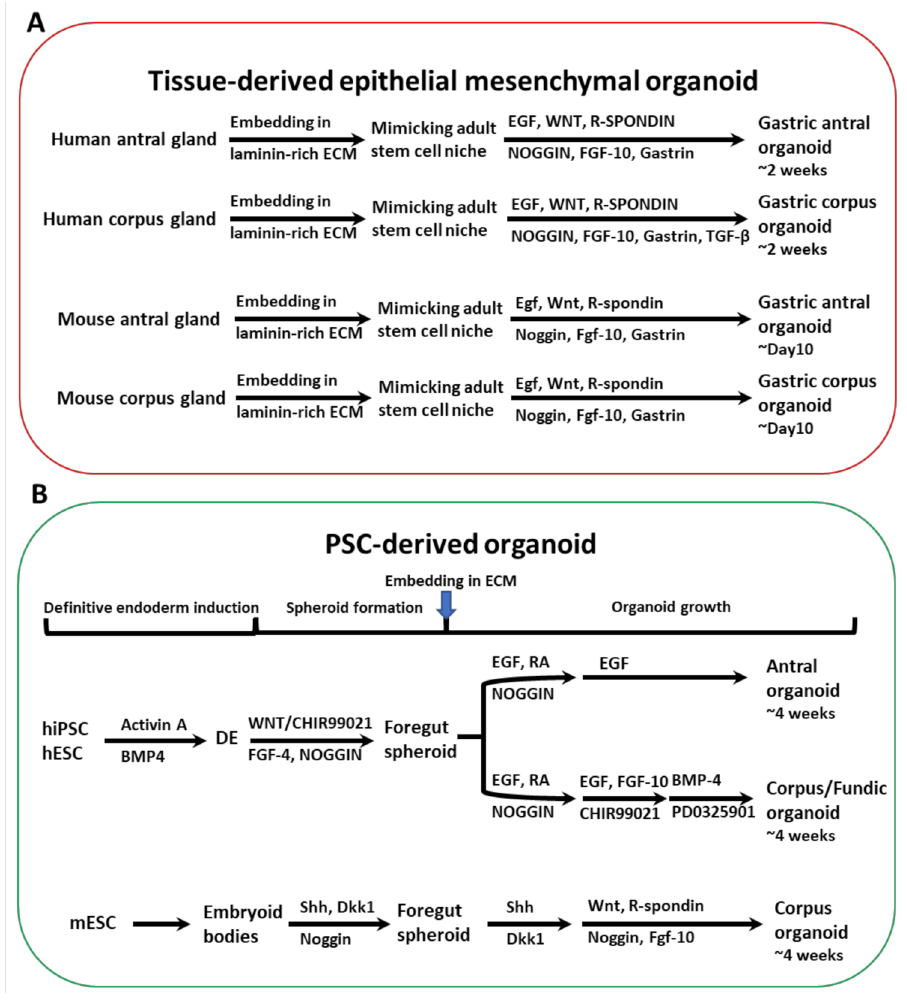
Figure 3. Generation of stomach organoids from tissue and pluripotent stem cells. ( A ) Mouse or human stomach antrum and corpus organoids were generated from the glands, embedded in ex- tracellular matrix (ECM), and cultured with medium supplemented with EGF, WNT, R-spondin, Noggin, FGF10, and gastrin. Suppression of TGF- β signaling increased the longevity of human stomach corpus organoids. ( B ) Differentiation of pluripotent stem cell (PSC)-derived human antrum and corpus organoids. PSCs were isolated from blastocysts (embryonic stem cells; ESCs) or repro- grammed to generate iPSCs. Cells were committed to differentiate into endoderm by treatment with Activin A and BMP4. Posterior foregut formation was achieved by culture with FGF4 and Wnt or CHIR99021. Noggin was inoculated in the case of foregut differentiation. ECM-embedded cells produced the 3D foregut spheroids. Differentiation into antral types was done using retinoic acid (RA) and EGF treatment. To produce foregut cell types, the organoids were exposed to CHIR99021, EGF, and FGF10. Mouse PSC-derived corpus organoids were generated by culturing the embryoid bodies and treatment with Sonic hedgehog (Shh), the WNT antagonist Dickkopf 1 (Dkk 1), as well as Noggin. ECM-embedding spheroids with exposure with FGF10, Noggin, WNT, and R-spondin produced corpus gland formation in mice